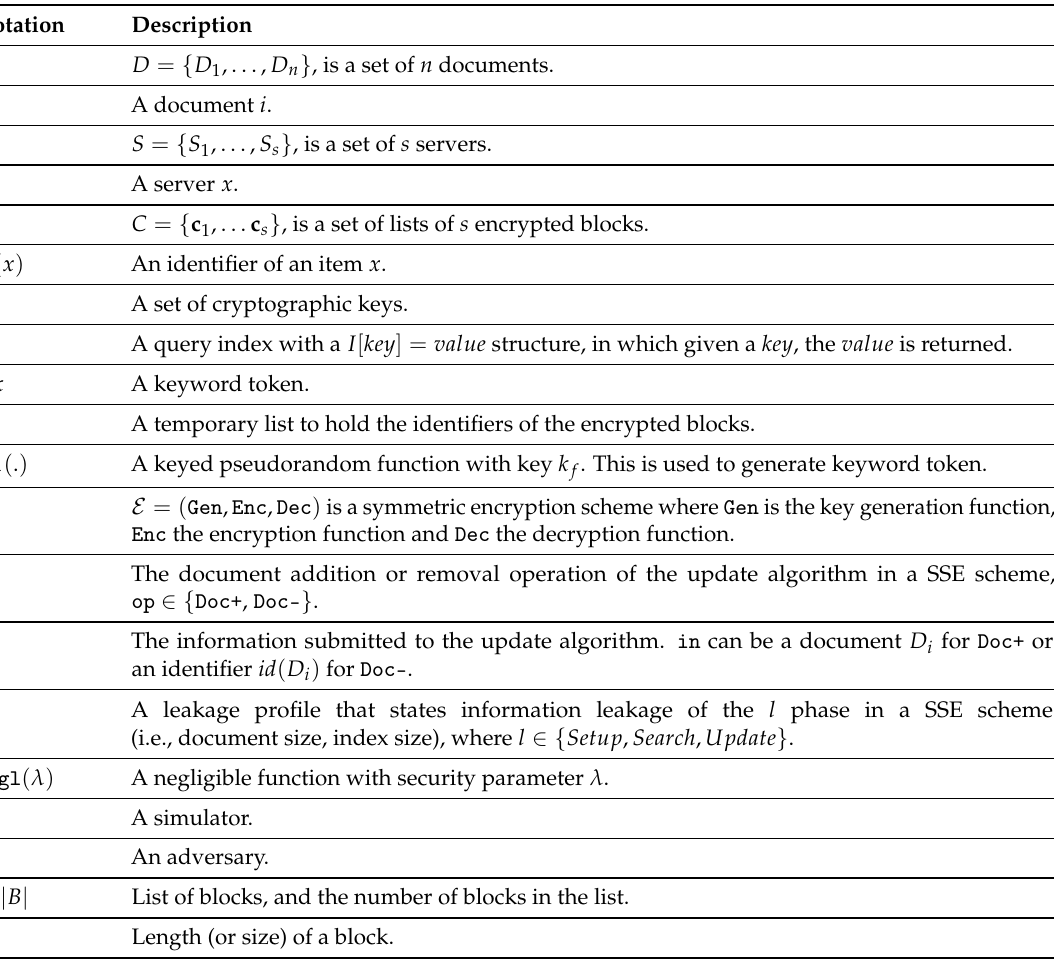
Table 1. Notations used in the description of the SSE